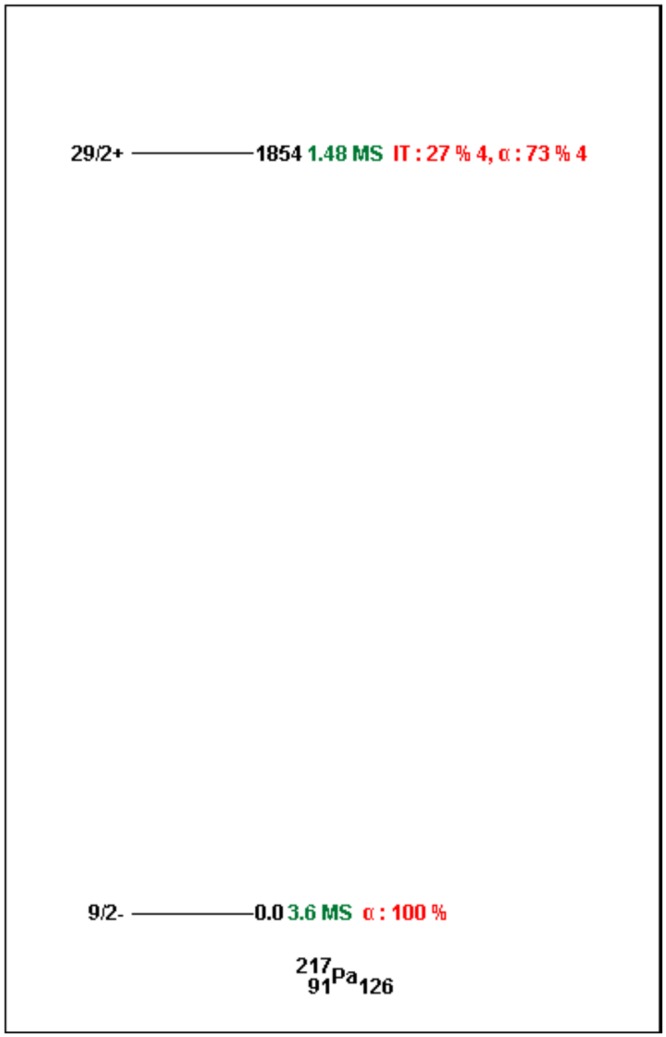
The complete decay scheme of 217Pa based on the current evaluation.